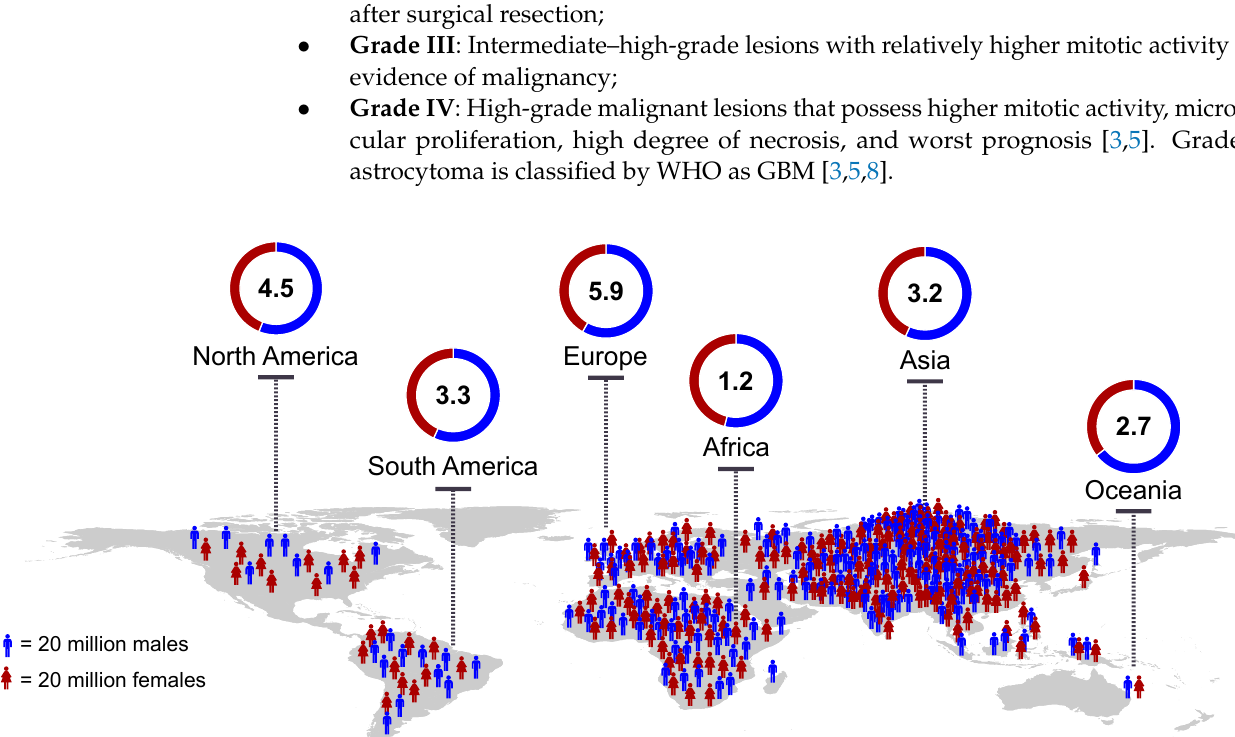
Figure 1. Global CNS tumor incidence rates. Age-adjusted global CNS tumor incidence rates (per 100,000 persons) and the proportions of diagnosed males (blue) and females (red) across all major continents. Number of people represents proportions of males and females in the overall population (downloaded from www.population.un.org, accessed on 10 December 2020). World map and incidence rate charts were plotted using R packages rworldmap and ggplot2,